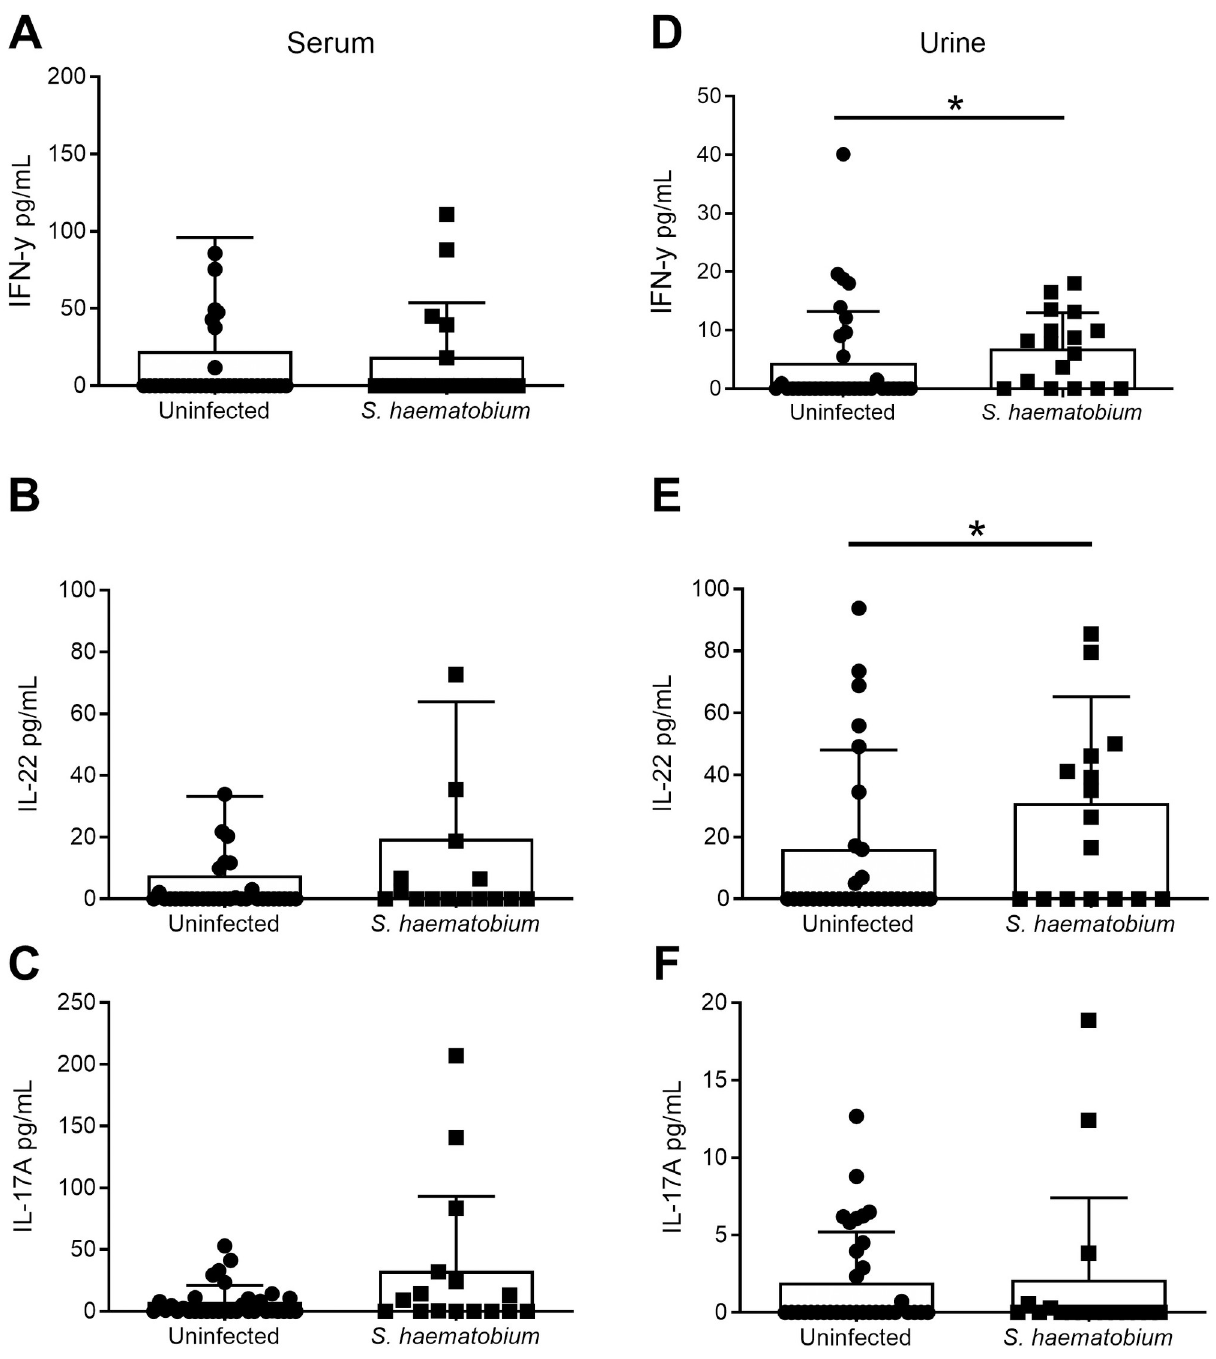
Fig 6. Cytokine (IFN γ , IL-22, and IL-17A) levels in serum or urine samples of Nigerian children infected with or without S . haematobium . (A-C) Serum and (D-F) Urine samples were measured for (A, D) IFN- γ , (B, E) IL-22, and (C, F) IL-17A levels in infected (n = 16–17) and uninfected (n = 34) children. � p <